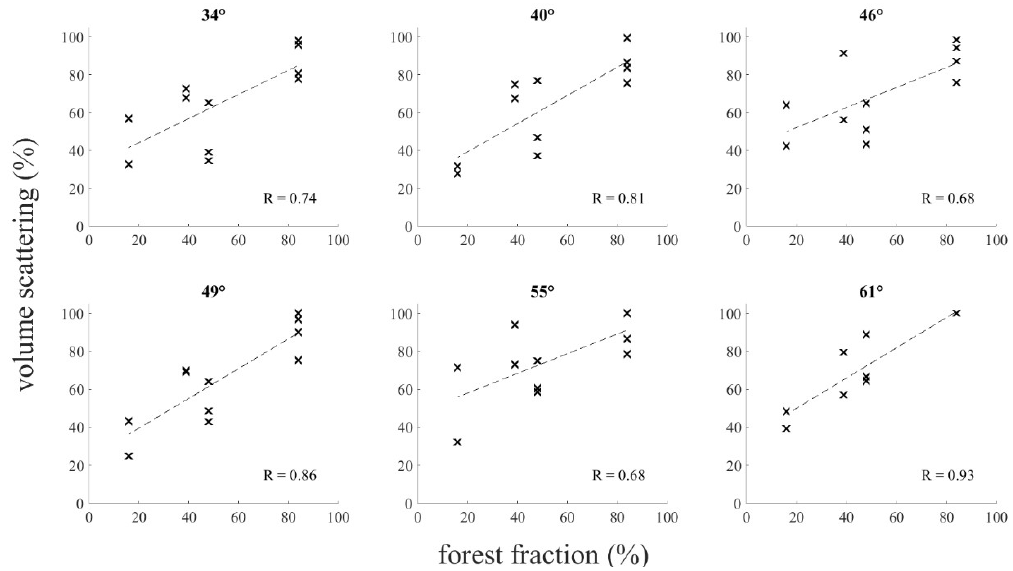
Figure 9. Volume scattering at 17.2 GHz vs. FF for the forested sites at each incidence angle. The line of best fit is for illustrative purposes only.